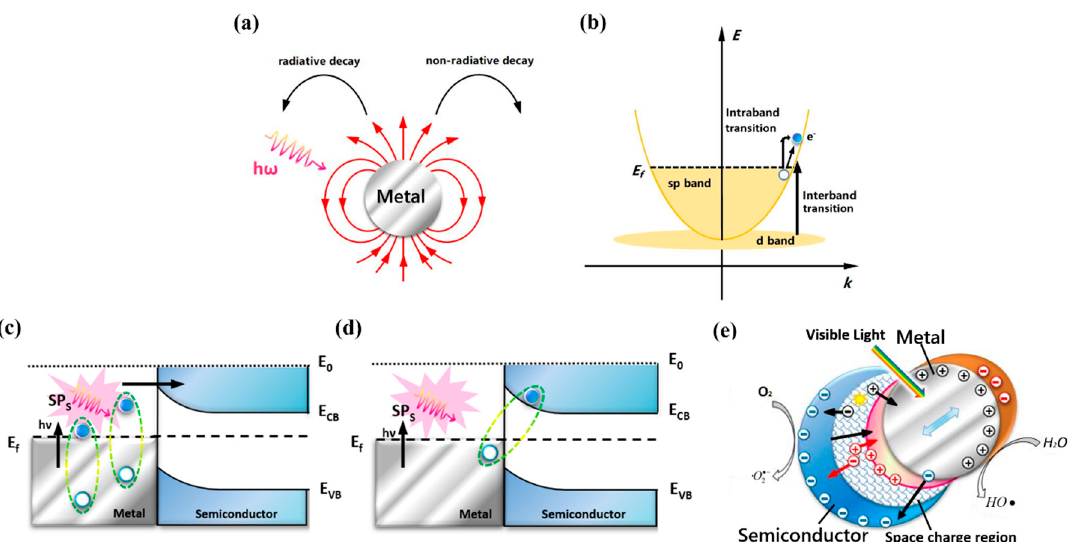
Figure 2. ( a ) The decay of excited surface plasmons (SPs) in plasmonic metal. ( b ) The transitions of hot carriers (HCs) in two ways, Intraband transition and Interband transition. ( c ) The scheme of transportation of HCs in plasmon induced hot-electron transfer (PHET) and ( d ) in plasmon induced metal-to-semiconductor interfacial charge transfer transition (PICTT). ( e ) The diffusions of HCs and the photocatalytic process of the redox reaction in plasmon-mediated heterostructure (PMH).